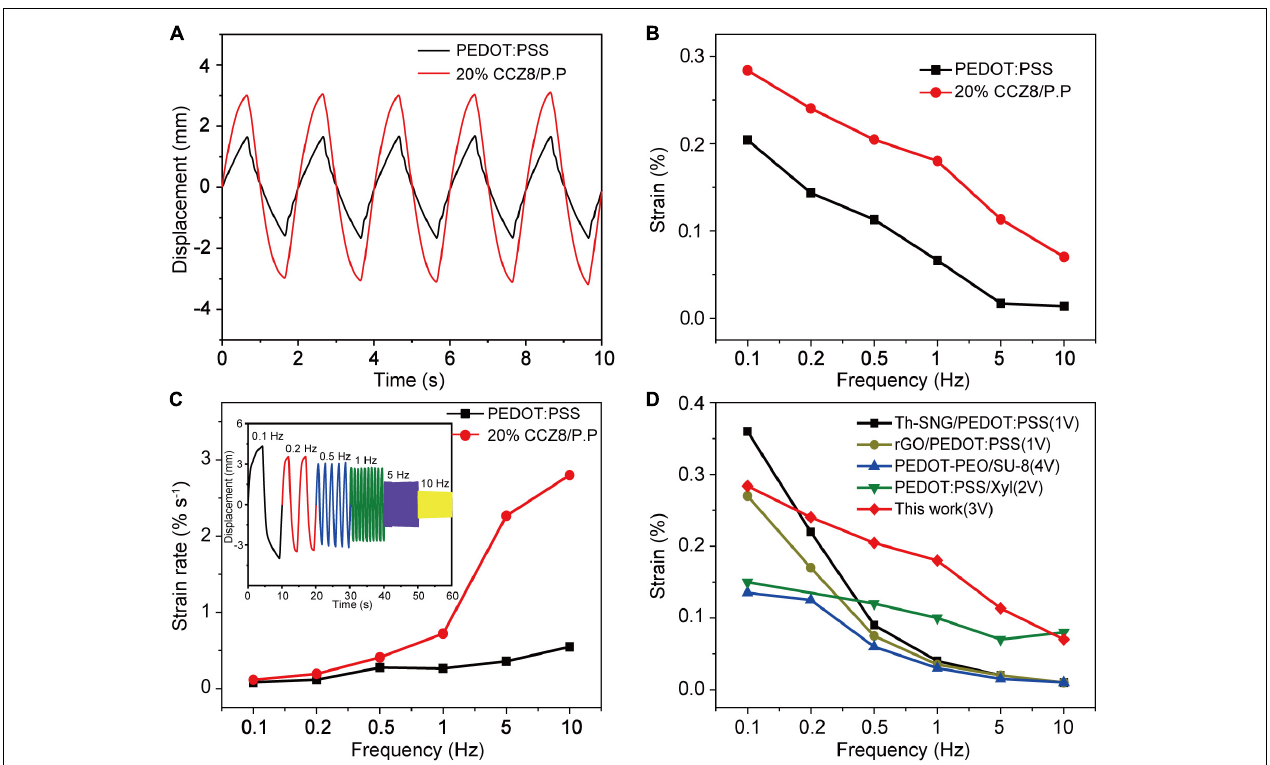
FIGURE 6 | Bending actuation performances of PEDOT:PSS and 20% CCZ8/P.P textile actuator. (A) Peak to peak displacement under 3 V at 0.5 Hz. (B) Strain difference under 3 V from 0.1 Hz to 10 Hz. (C) Strain rate under 3 V from 0.1 Hz to 10 Hz. Inset: displacements of 20% CCZ8/P.P textile actuator with increasing frequencies. (D) Comparison of bending strain difference–frequency curves of the reported PEDOT:PSS based actuators dealing with low-voltage